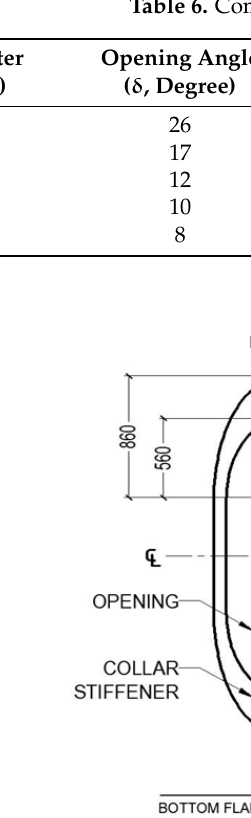
Table 6. Comparison of elastic buckling stress ( L = 9).